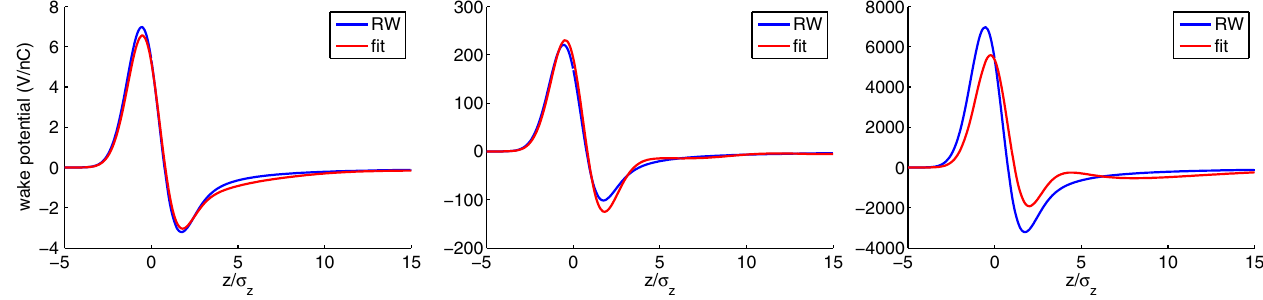
FIG. 18. Comparisons between wake potentials of the resistive wall impedance and of the fit with 18 resonant modes for Gaussian bunches of 2 m (left), 0.2 m (center), and 0.02 m